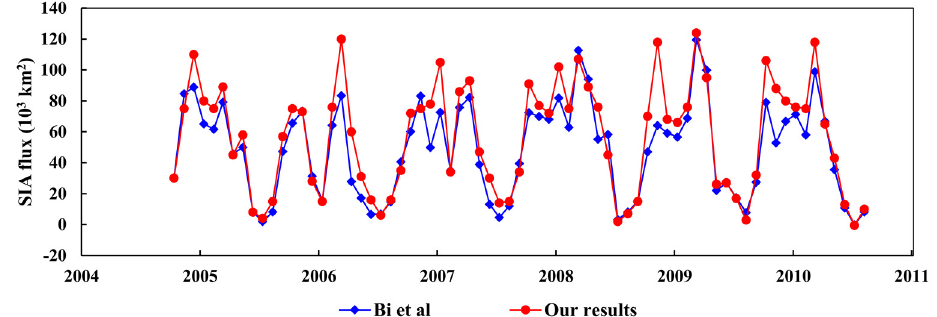
Figure 11. Comparisons of monthly SIA outflow through the Fram Strait from October 2004 to August 2010 between our results and [49].